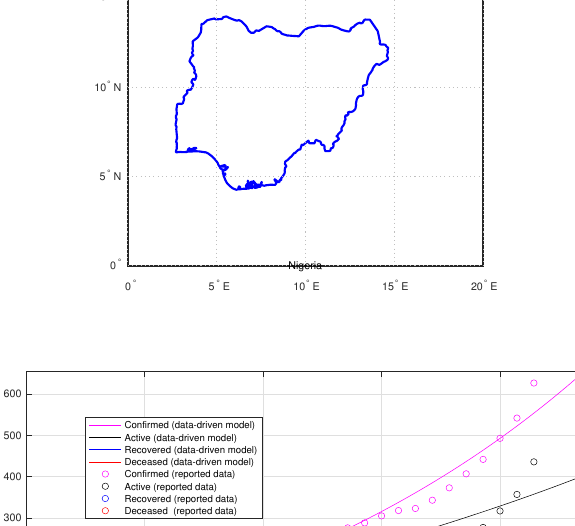
Confirmed (data-driven model) Active (data-driven model) Recovered (data-driven model) Deceased (data-driven model) Confirmed (reported data) Active (reported data) Recovered (reported data) Deceased (reported data)